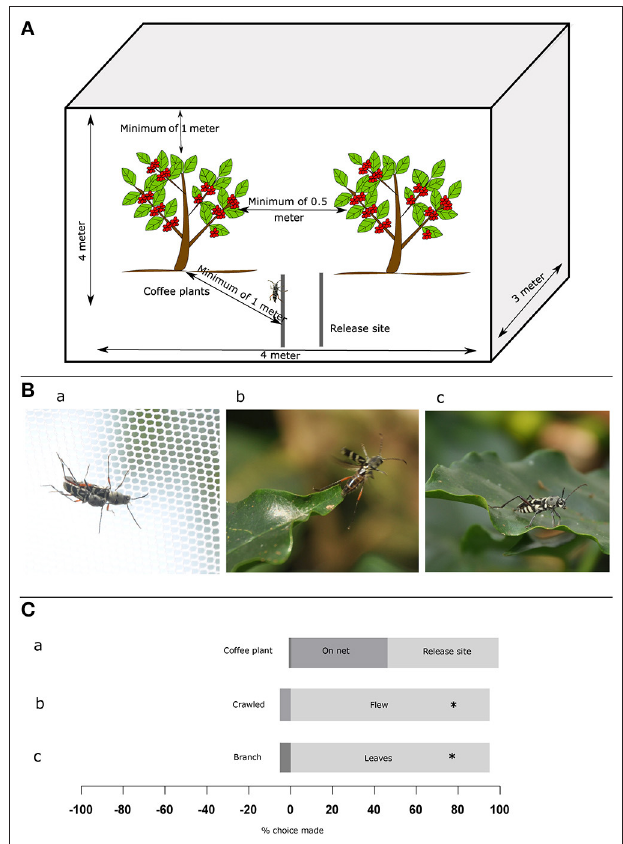
FIGURE 1 | Experimental set-up and behavior of Coffee White Stem Borer (CWSB). (A) Top: Schematic illustration of the experimental setup. The setup is of size 4 × 3 × 4m (l × b × h) covering two coffee plants and CWSB were released on two PVC pipes 1m from both plants. (B) Images of CWSB. (a), mating on cage net (b), flying (c), landing on coffee leaves. (C) Mating site preference and behavioral approach of CWSB. (a), Mating location ( n = 72) (b), Host plant approach ( n = 38) (c), Host plant landing location ( n = 37). * p < 0.005, Chi-square test. See Supplementary Table 1 for statistical